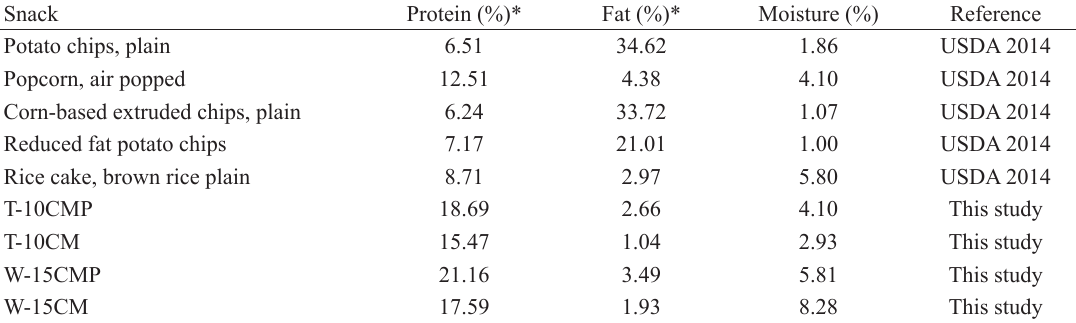
Nutritional composition of the